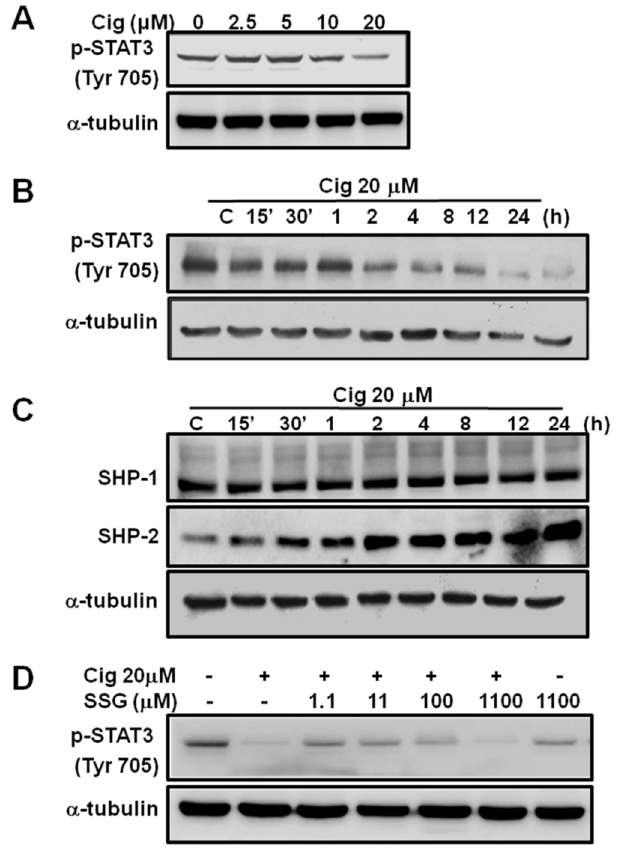
Figure 4. The suppression of phosphorylation of STAT3 at Tyr705 by ciglitazone is highly related to SHP-2 activation. U87 were treated with ciglitazone in a dose-dependent course or time-dependent course and analyzed phospho-STAT3 (Tyr 705), SHP-1, and SHP-2 by Western blotting. ( A ) Representative of expression of P-STAT 3 in the different concentration of ciglitazone harvested 24 h after the treatment. ( B ) Representative of expression in p-STAT3 related to different time profile at the treatment of ciglitazone of 20 µ M. ( C ) U87 were treated with ciglitazone in a dose and time dependent manner and then analyzed in SHP-1 and SHP-2 expression by Western blotting. ( D ) U87 were treated with sodium stibogluconate (SSG), a protein tyrosine phosphatase inhibitor, at the indicated concentration for 24 h and analyzed in phospho-STAT3 (Tyr 705) by Western blotting. α -tubulin were loaded as